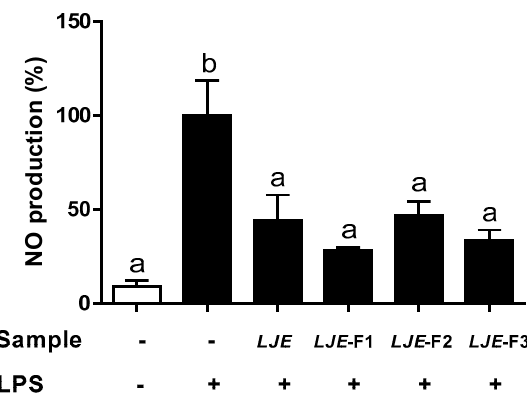
Figure 3. Effects of LJE and LJE-Fs on nitric oxide (NO) production in the lipopolysaccharide (LPS)-stimulated Caco-2 cells. Caco-2 cell monolayers were incubated for 6 h with 100 μ g/mL LJE, LJE-F1, LJE-F2, or LJE-F3. Then, 1 μ g/mL LPS was added, and the cells were incubated for an additional 24 h. Values are mean ± SEM of three independent experiments. Values that do not share the same superscript are significantly different by one-way ANOVA with Tukey’s comparisons test ( p <0.05). 3.4. LJE and LJE-Fs Protected Caco-2 Cell Monolayers from Endotoxin Stimulus Next, we evaluated the preventive effects of LJE and LJE-Fs on intestinal epithelial barrier function disrupted by LPS stimulus in polarized Caco-2 cell monolayers by measuring TEER (Figure 4). Time zero (T 0 )-TEER values were measured before 100 μ g/mL LJE or LJE-Fs were added to the